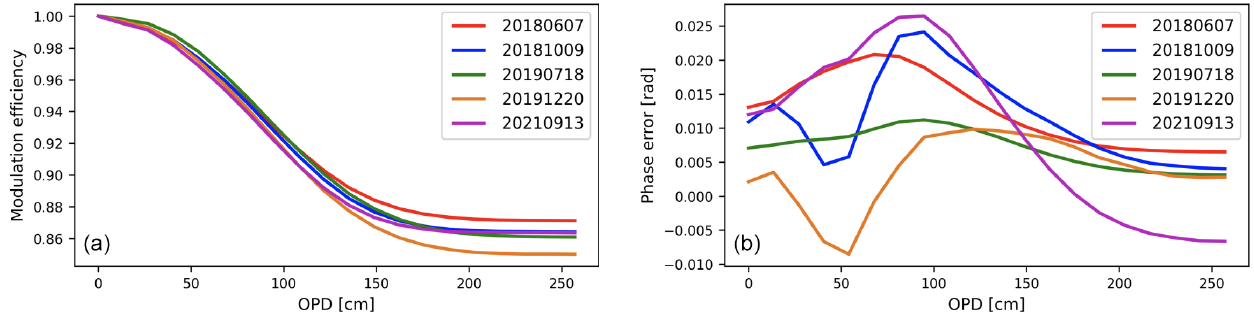
Figure 2. The retrieved modulation efficiency (a) and phase error (b) from the HBr cell measurements on 7 June 2018, 9 September 2018, 18 July 2019, and 13 September 2021 by the LINEFIT14.5